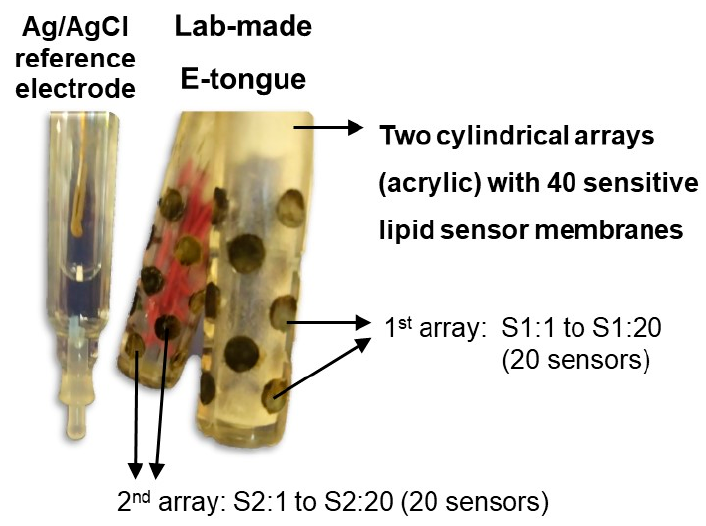
Figure 3. Lab-made E-tongue comprising two cylindrical sensor arrays, each with 20 lipid-poly- meric sensor membranes (adapted with permission from Ghrissi et al. [26] ©MDPI, 2022)